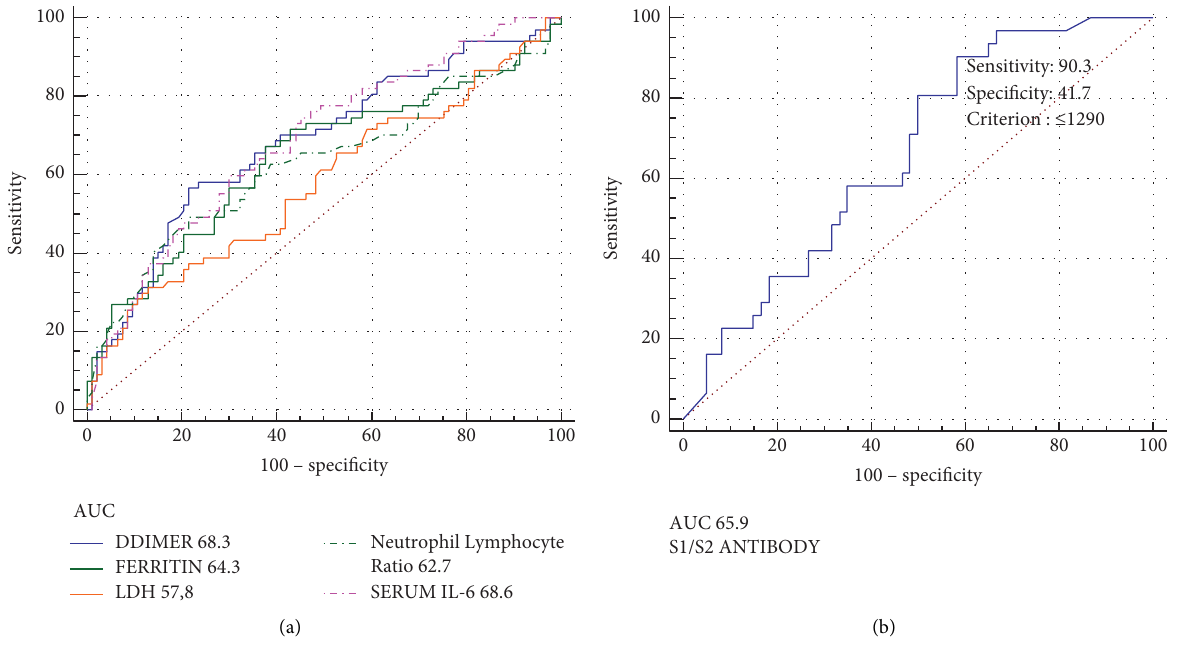
Figure 2: (a): ROC (receiver operator characteristic) curve for D-dimer, Ferritin, LDH, IL-6 and NeutrophilLymphotye Ratio as a predictor of mortality. (b): ROC Curve for S1S2 Neutralizing Antibodies as a predictor of mortality. Sensitivity of S1S2 antibody is higher (AUC: 65.9%) as compared to infammatory markers. LDH � lactatedehydrogenase, IL6 � interleukin